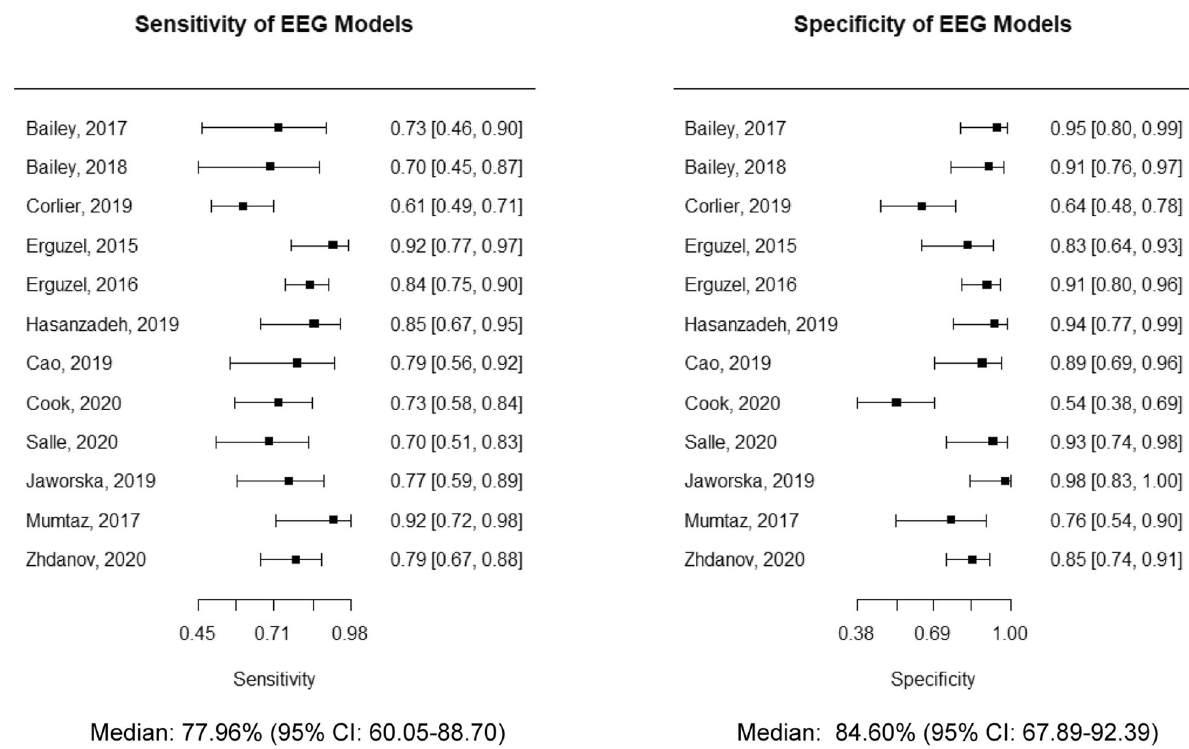
Fig. 2 Sensitivity and speci fi city across models. A calculation of the sensitivity and speci fi city summary statistics across 12 studies using the frequencies of true positives, false negatives, false positives, and true negatives, using the madad function in the mada package in R. Overall, the balanced accuracy (sensitivity + speci fi city/2) across studies was 81.28%. Across studies, model sensitivity was lower than speci fi city, suggesting that predictive models of treatment response using EEG overall show better performance in identifying true non-responders to treatment (speci fi city), relative to true responders to treatment